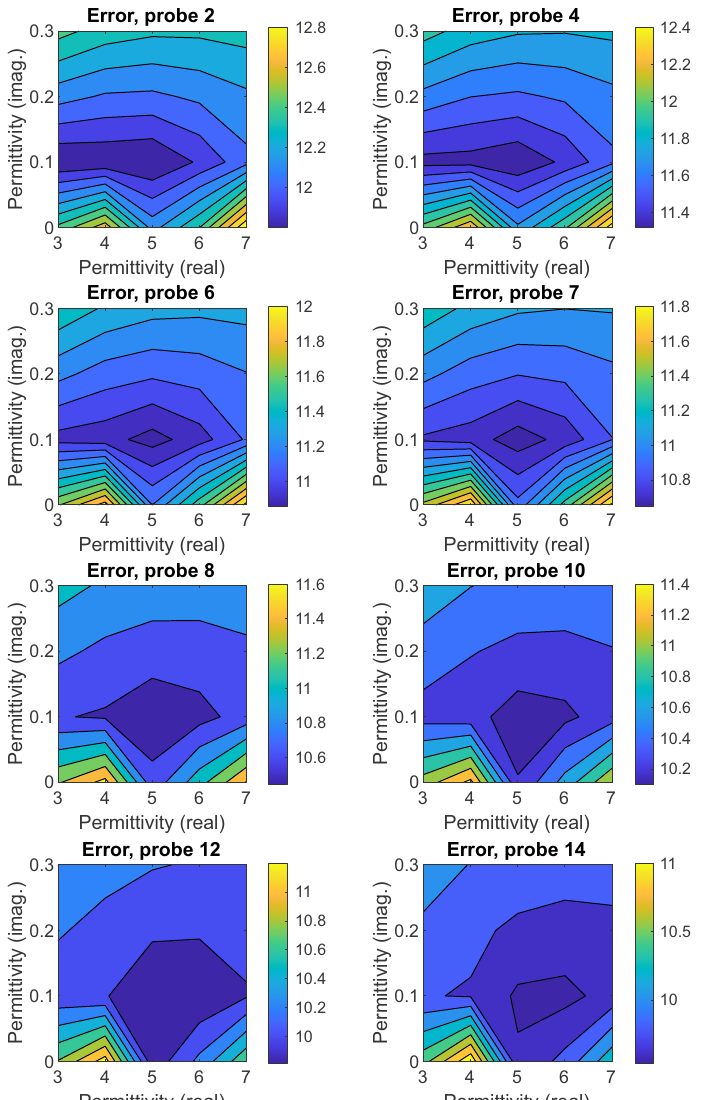
Figure 11. Average error between simulated and measured data, considering AIR and MUT, for different scenarios in which the complex permittivity of the floor and probe were changed. In this case, all the samples were used and the error was not normalized. For brevity, we reported only the even probes (2, 4, 8, 10, 12 and 14) and probe 7, to have an even number of